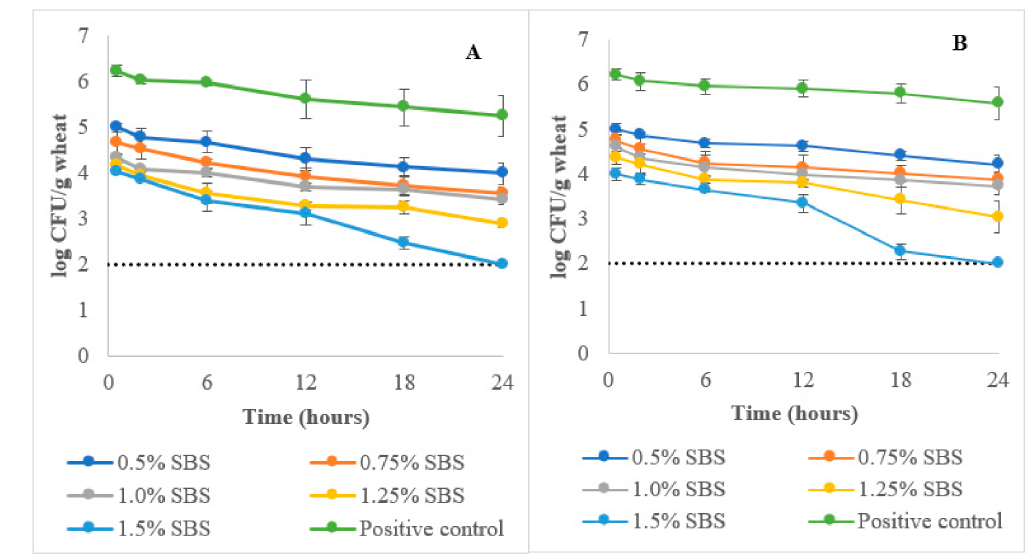
Figure 1. E. coli O121 ( A ) and O26 ( B ) load reductions in wheat during tempering; control corresponds to 0% SBS tempering treatment; dashed line corresponds to the limit of detection (2.0 log CFU/g